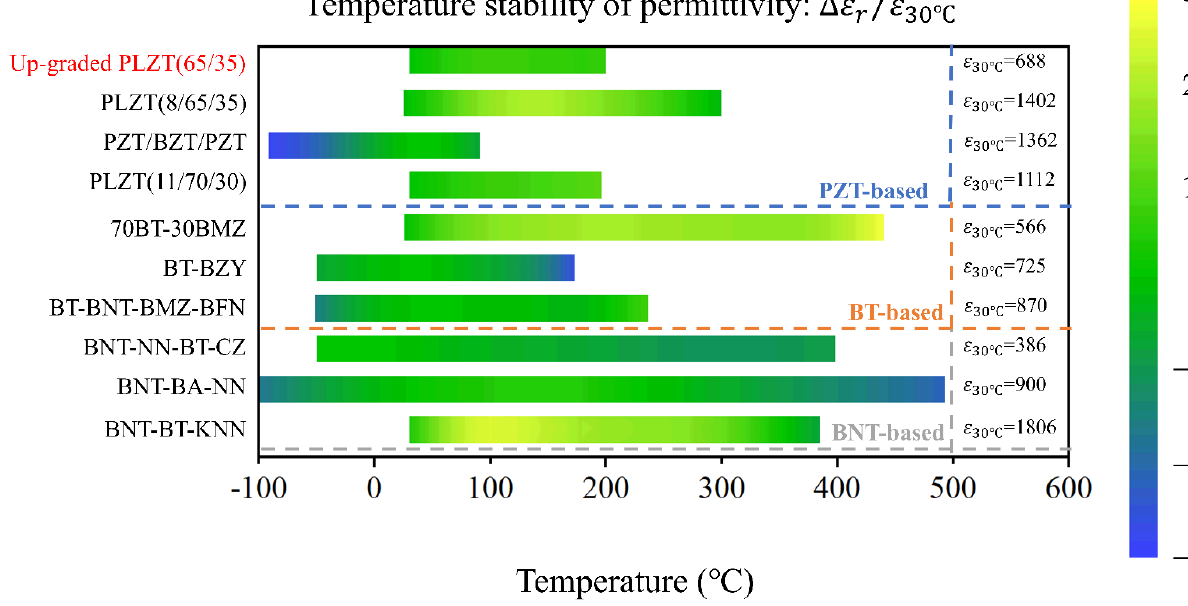
Figure 5. Comparison of temperature stability of dielectric constant between up-graded PLZT thin film and other dielectric materials. film and other dielectric